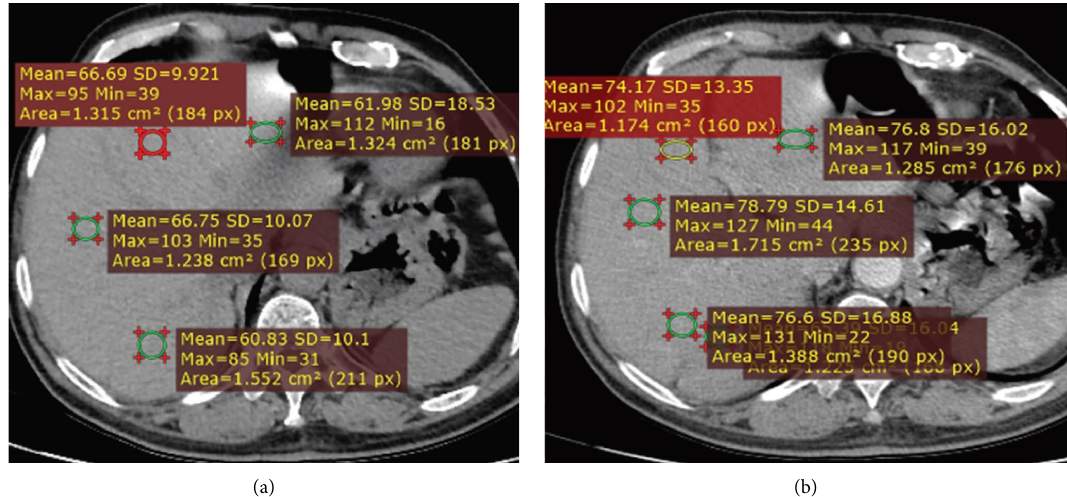
Figure 6: Axial precontrast (a) and postcontrast portal venous phase (b); axial CTscans at the same level taken in TASH, 2022 G.C, show mean hepatic attenuation at the four diferent locations of measurement. Mean hepatic attenuation was 64HU on precontrast and 76.5HU on PVP with CEI of 12.6HU which is signifcantly lower than the expected minimum CEI of 50HU.